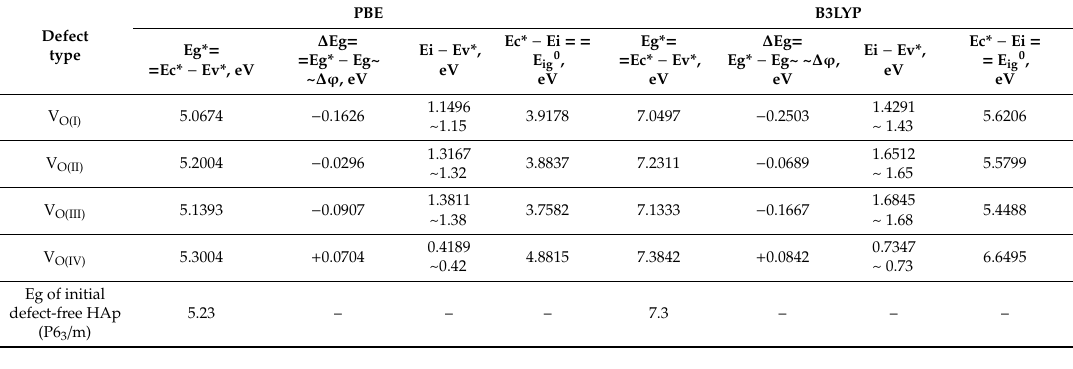
Table 4. Data for O vacancy from PO 4 in di ff erent position and symmetry (average errors ± 0.05 eV).